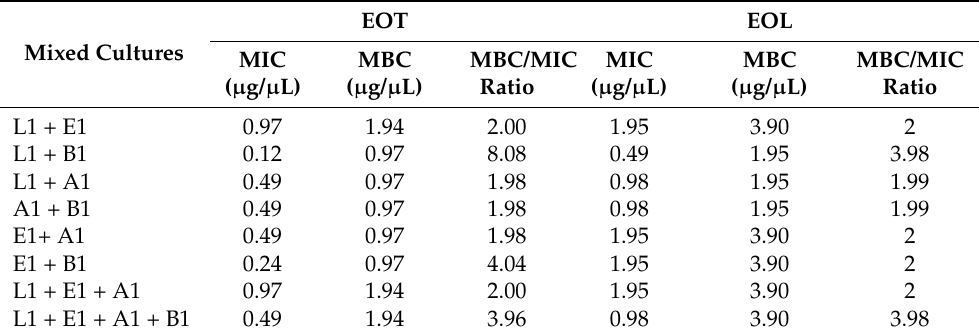
Table 6. Minimal inhibitory concentration and minimum bactericidal concentration against microbial combinations (mixed cultures).